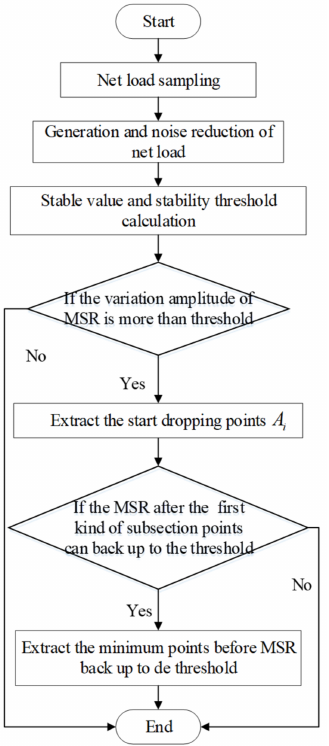
Figure 3. Flow chart of dispatch time division based on